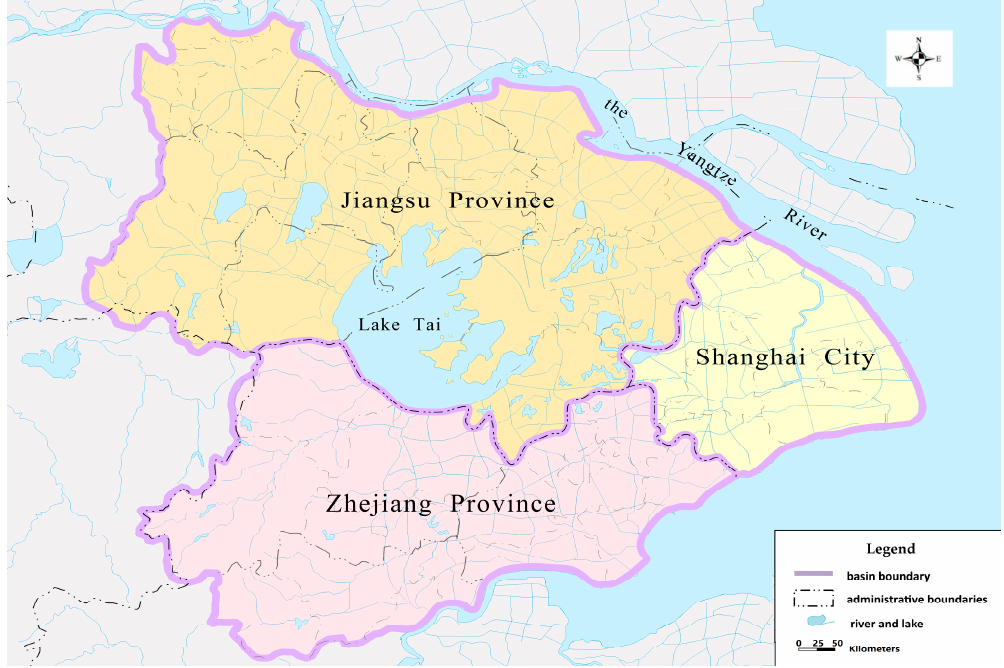
Figure 2. The map of the main administrative division of the Taihu Basin. According to the materials of the Taihu Basin and Southeast Rivers Water Resources Bulletin and the Water Quality Bulletin of Taihu Basin and Important Water Function Areas of Southeast Rivers, and others, the pre-configuration allocation plan of the initial water rights for the Taihu Basin can be set as follows: the ratios of the initial water quantity rights of Jiangsu province, Zhejiang province, and Shanghai city are, respectively, 35.62%, 31.94%, and 32.45%. Furthermore, the area of those three provinces are 19,399 square kilometers, 12,093 square kilometers, and 5178 square kilometers, respectively. The specific relevant data of the Taihu Basin from 2011 to 2014 are shown in Table